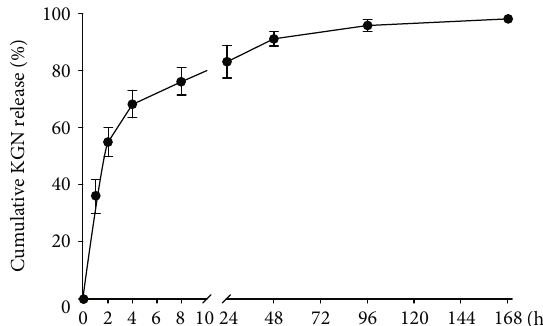
Figure 1: KGN release rate from the FG-KGN complex. Within 2 hours, the release rate of KGN was high, reaching about 60% of the total release amount. The release rate gradually decreased at 4 hours, and then remained steady between 4 and 96 hours. At 96 hours, KGN was mostly released from the FG-KGN